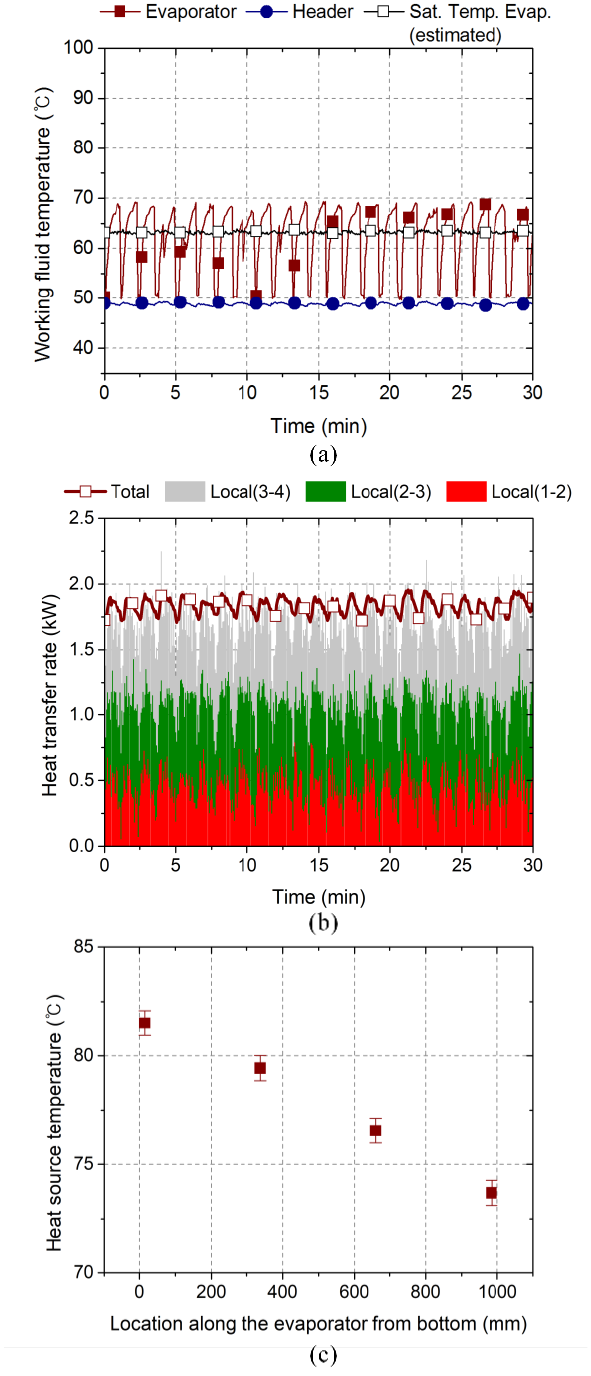
Figure 16. Operating characteristics of an FHP with a heat source temperature of 81.2 °C: ( a ) working fluid temperature, ( b ) cumulative heat transfer rate, and ( c ) local heat source temperature.